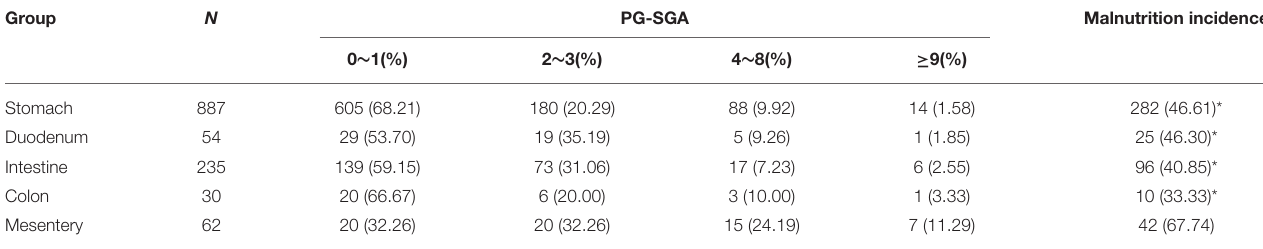
TABLE 4 | Location of gastrointestinal stromal tumors and incidence of nutritional risk ( N = 1,268) [n(%)].